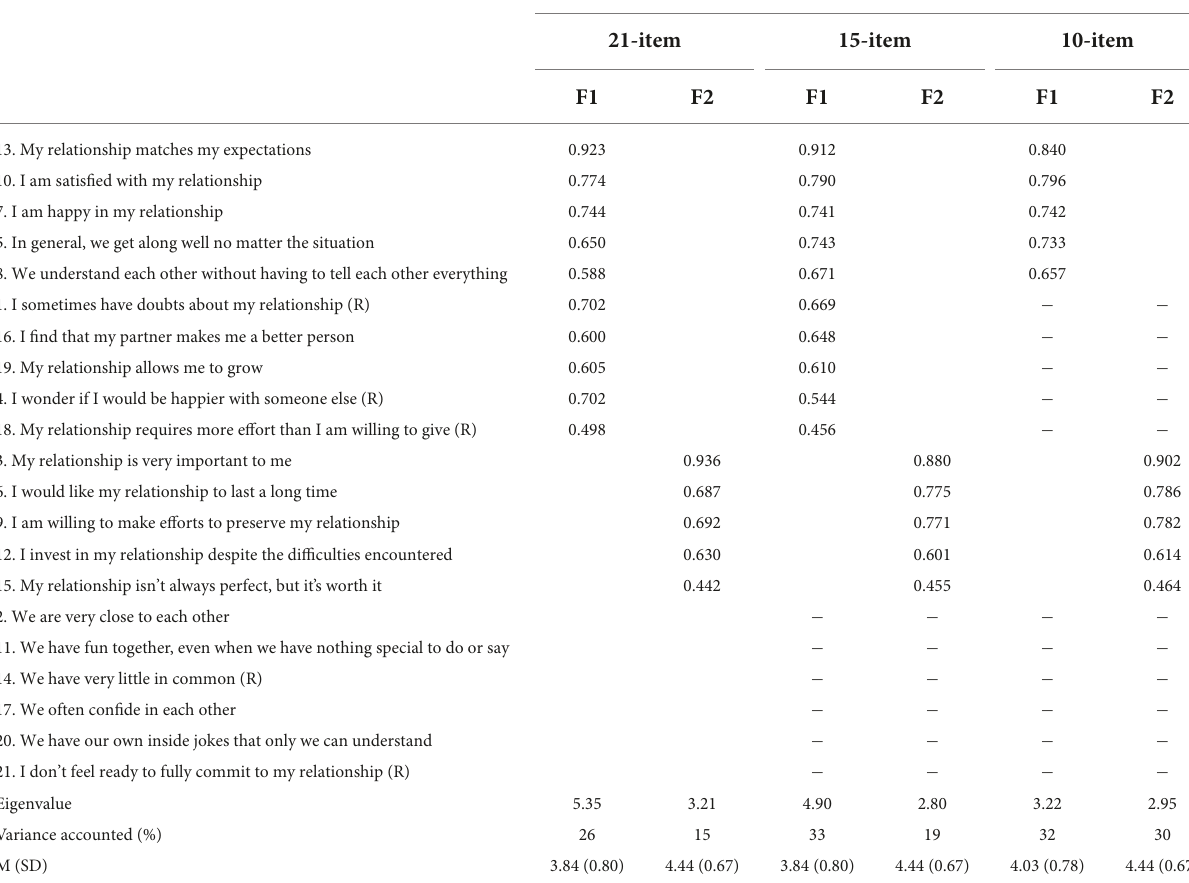
TABLE 2 Means, standard deviations, and factor loadings of the exploratory factor analysis (EFA) ( n 1 = 310). Items